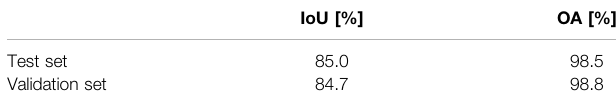
TABLE 3 | Performance statistics of the applied DL